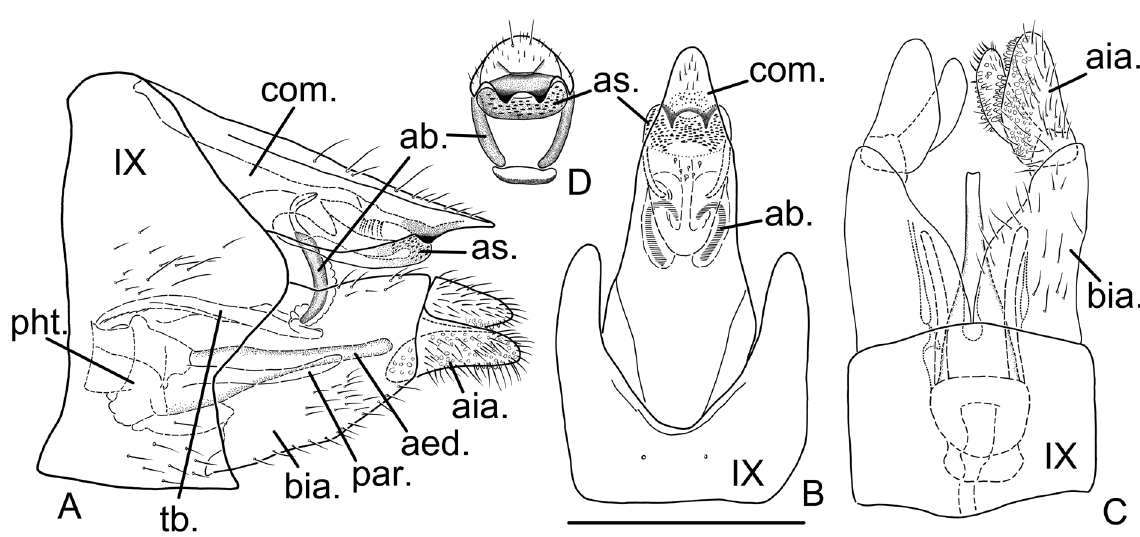
Fig. 1. Rhyacophila linguiformis sp. nov., male genitalia. A . Lateral view. B . Dorsal view. C . Ventral view. D . Complex of preanal appendages and apicodorsal lobe of segment IX, caudal view. Scale bar: 0.5